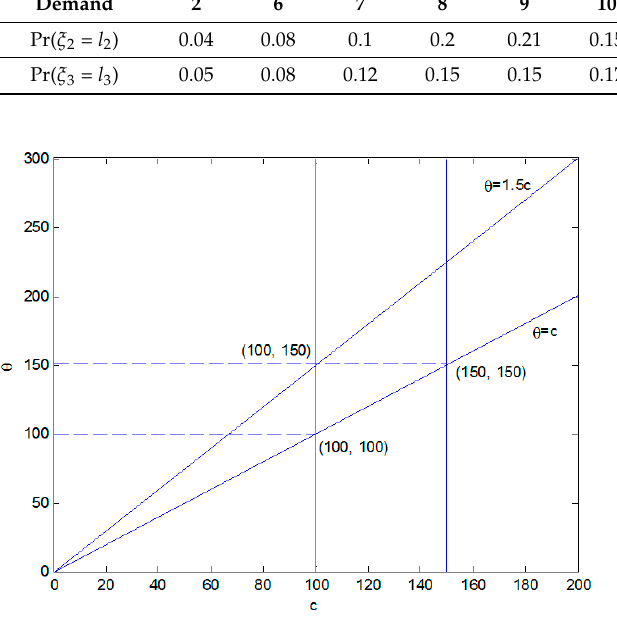
Figure 1. The function of θ on c ( n = 3)